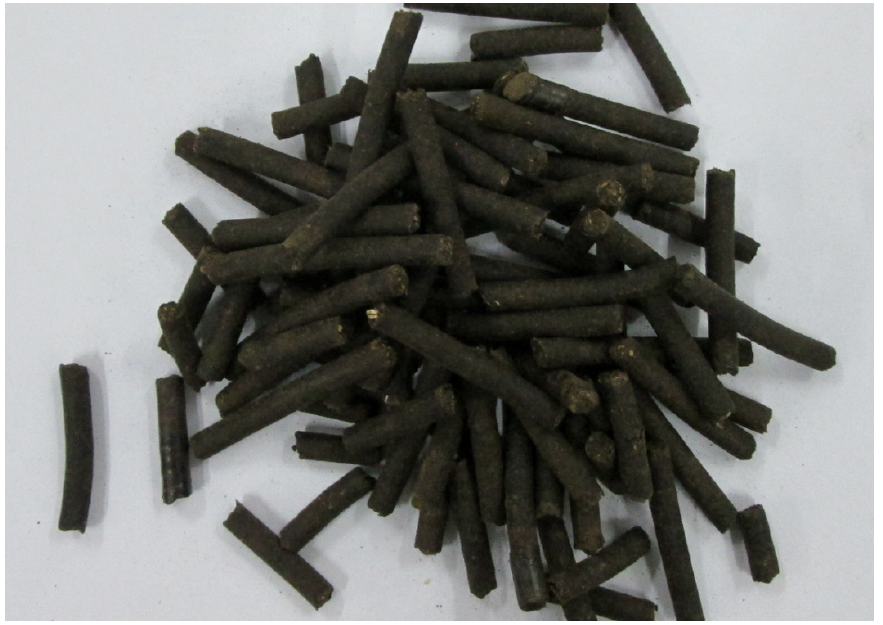
Figure 4. Pellets produced in the granulation process. Table 2. Properties of solid